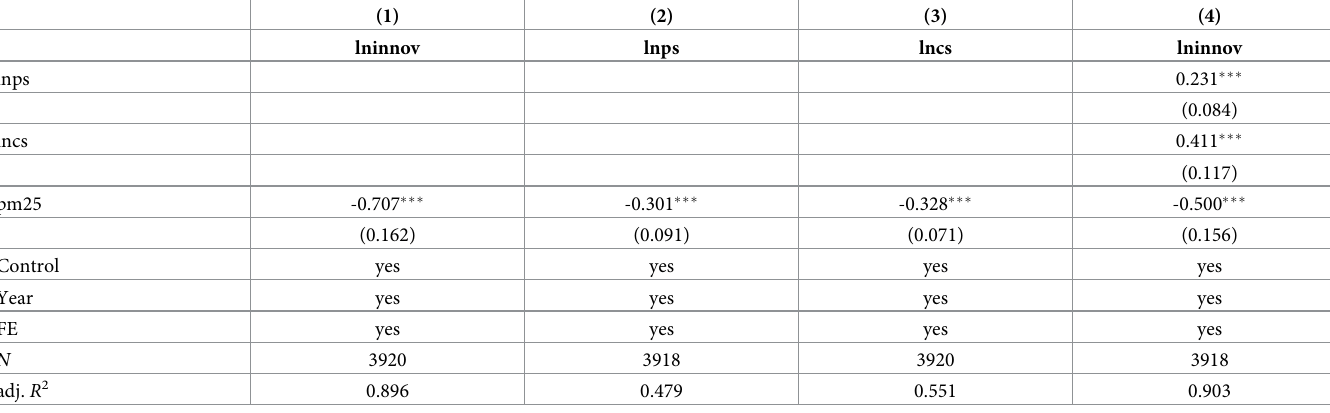
Table 7. Producer services (ps) and Consumer services